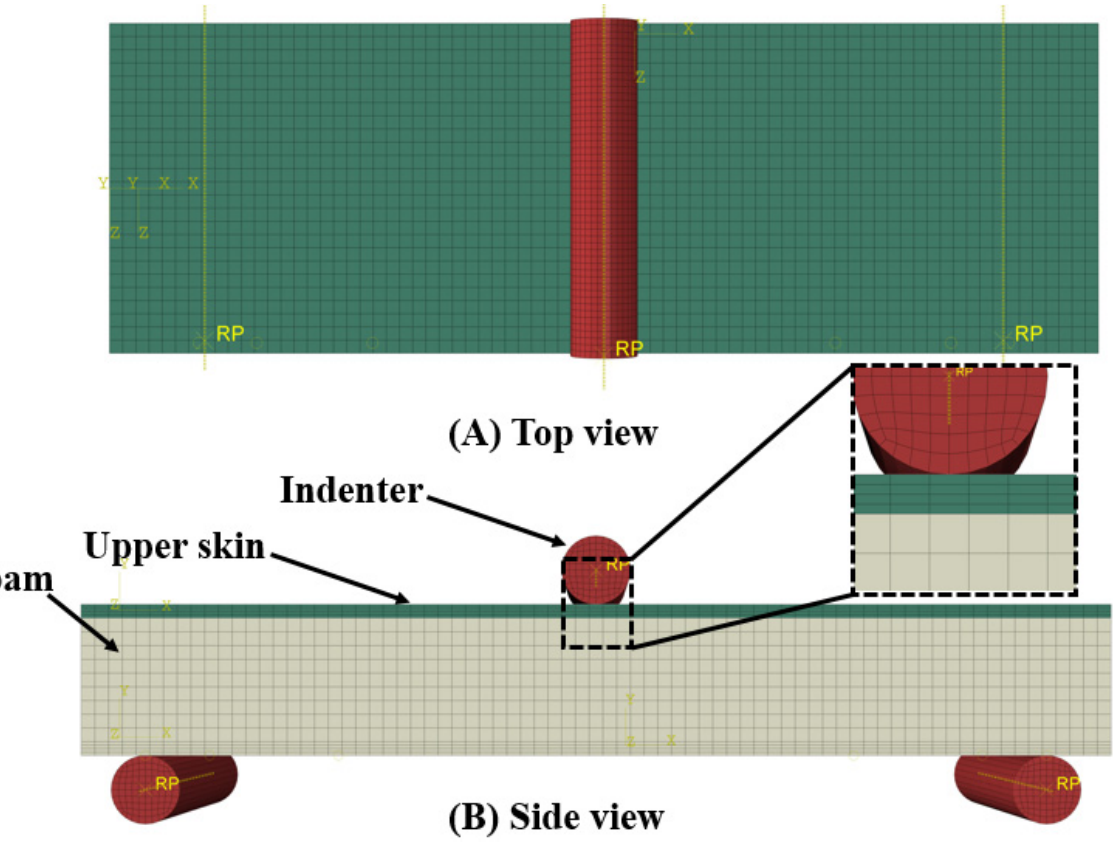
Figure 3. Three-point bending test system; (A) Top view, (B) Side view.